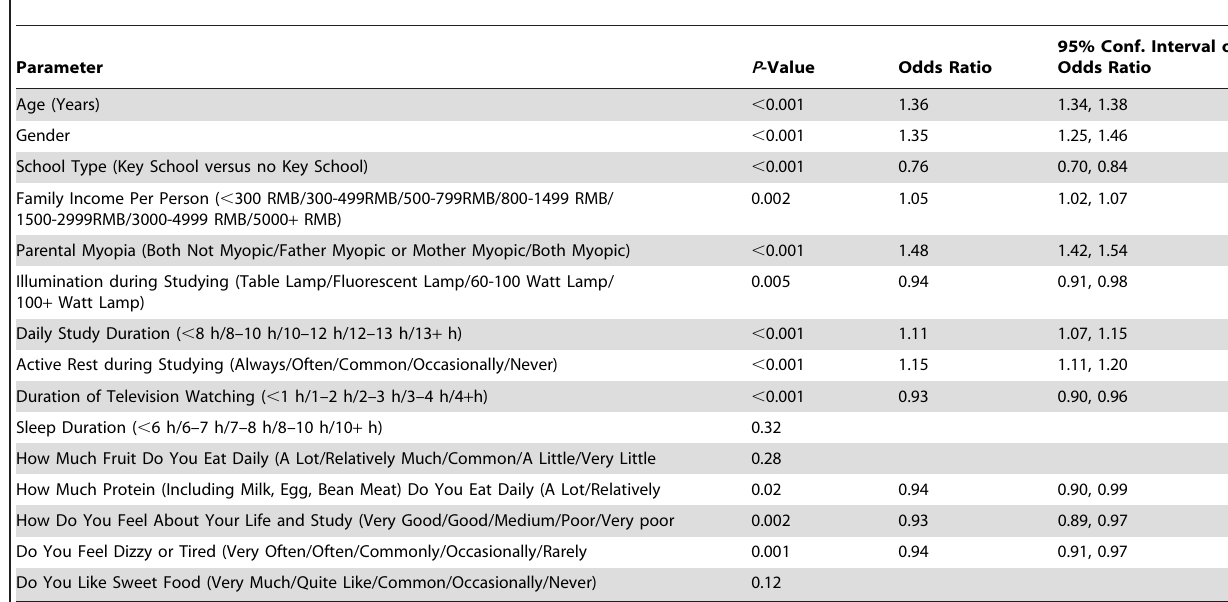
Table 3. Results of the multivariate analysis of the prevalence of myopia (defined as refractive error #2 1.00 diopters in the worse eye) and ocular and systemic parameters in the Beijing Pediatric Eye Study.